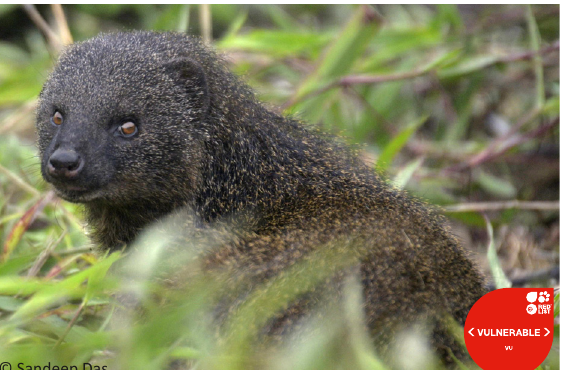
© Sandeep Das Image 16. Brown Mongoose Herpestes fuscus